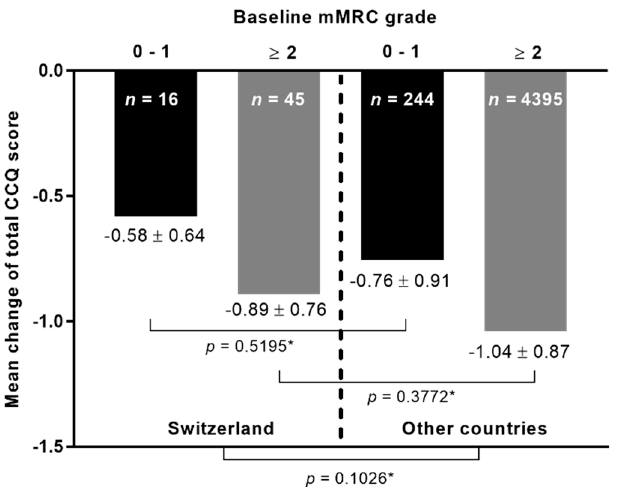
Figure 1. The mean change in the total CCQ score at visit 2 according to baseline mMRC grade. n : Number of patients. * Kruskal–Wallis test.